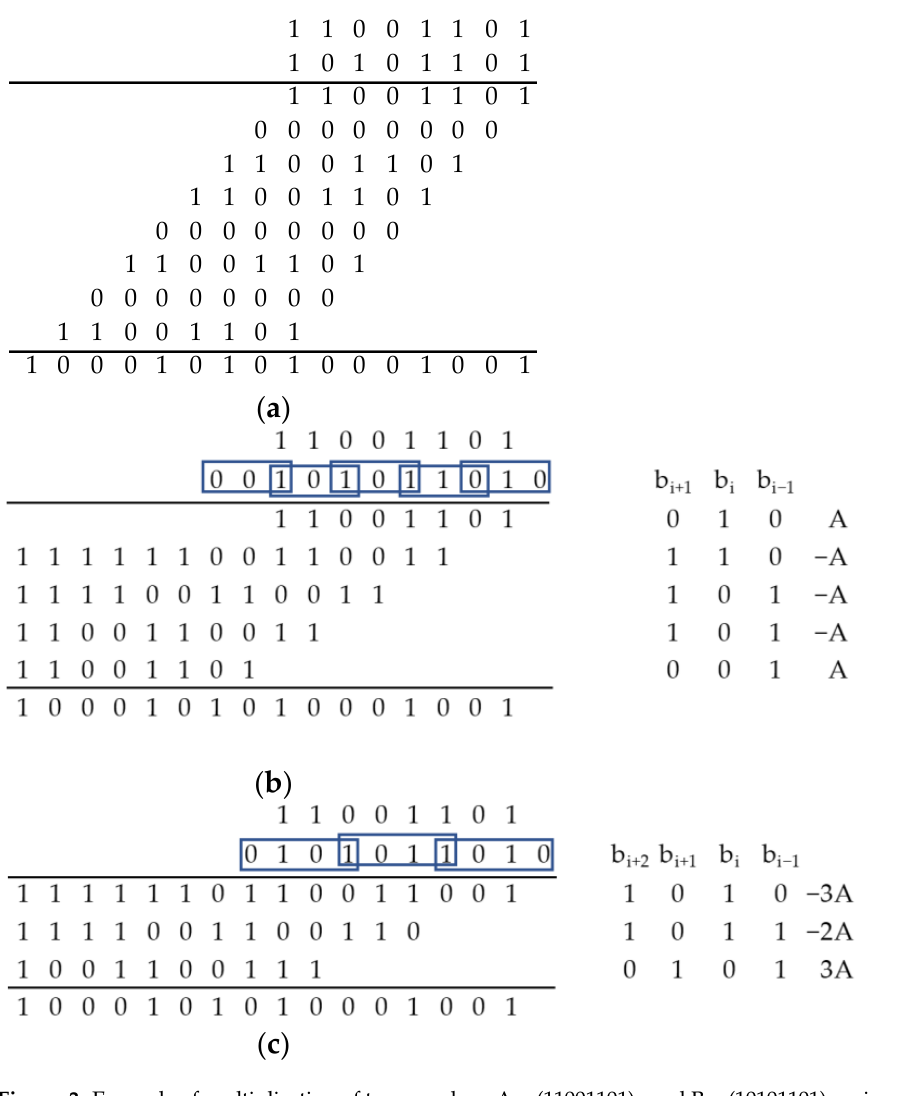
Figure 3. Example of multiplication of two numbers A = (11001101) 2 and B = (10101101) 2 using different algorithms: ( a ) traditional multiplication algorithm; ( b ) Booth ’ s algorithm; ( c ) proposed algorithm.